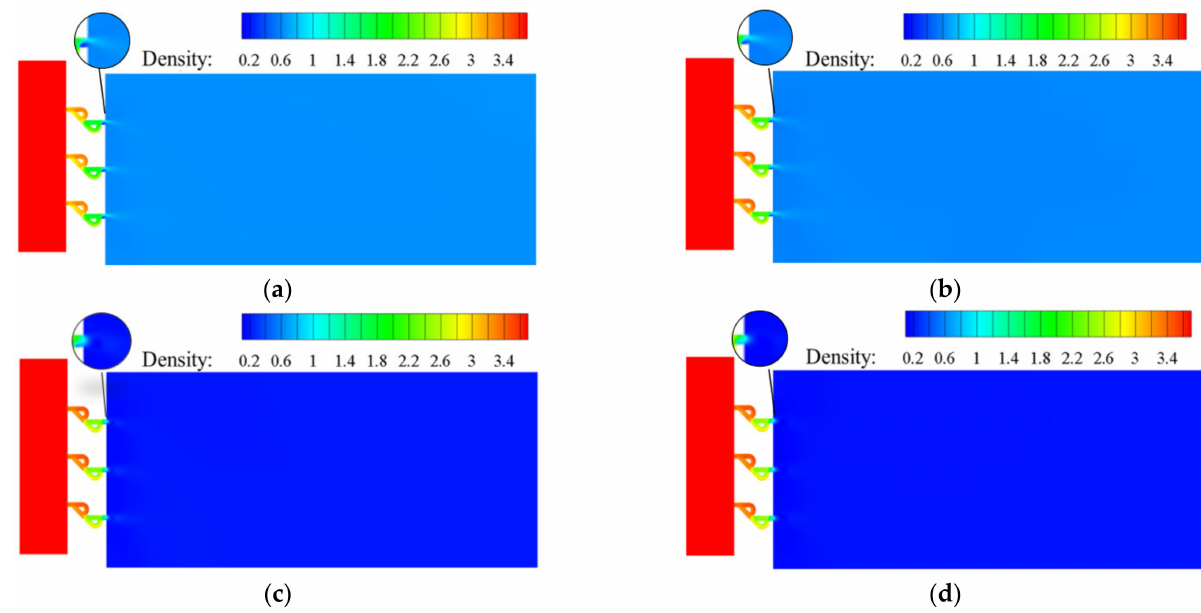
Figure 8. Density distribution on the symmetry plane for Tesla-type orifice structure under different mass flow rates (density in kg m − 3 ). ( a ) Q m = 0.02 kg s − 1 . ( b ) Q m = 0.1 kg s − 1 . ( c ) Q m = 0.5 kg s − 1 . ( d ) Q m = 1 kg s − 1